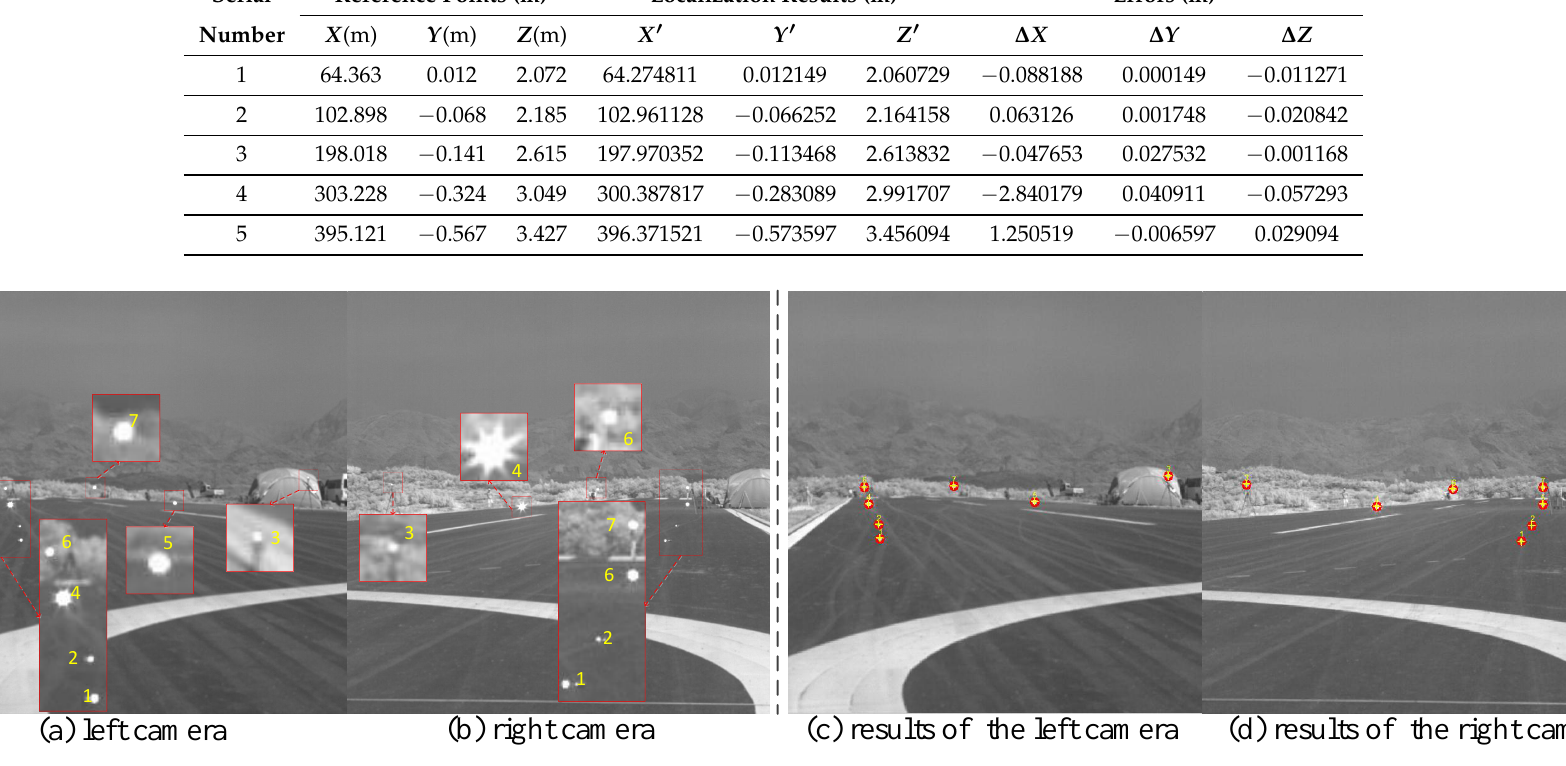
Figure 7. Verification of calibration results(red circles in ( c ) and ( d ) are real positions of the control points, the positions of yellow crosses are calculated by re-projection based on calibration